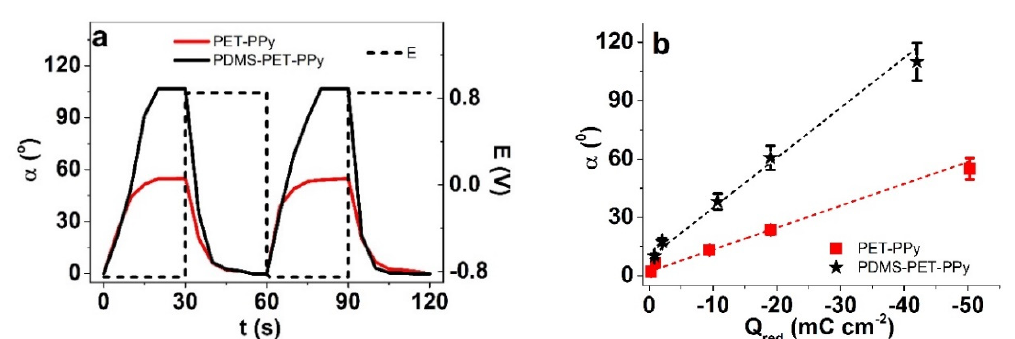
Figure 5. Square wave potential step measurements (aqueous NaDBS + TMACl, ± 0.85 V) with angular displacement α of bilayers showing ( a ) two subsequent cycles (third-fourth cycle, 0.017 Hz) of PET-PPy bilayer (red line) and (PDMS)PET-PPy (black line) with applied potential E against time t . The angular movement α of PET-PPy ( ■ ) and (PDMS) PET-PPy ( ★ ) against charge density Q red upon reduction is shown in ( b ).